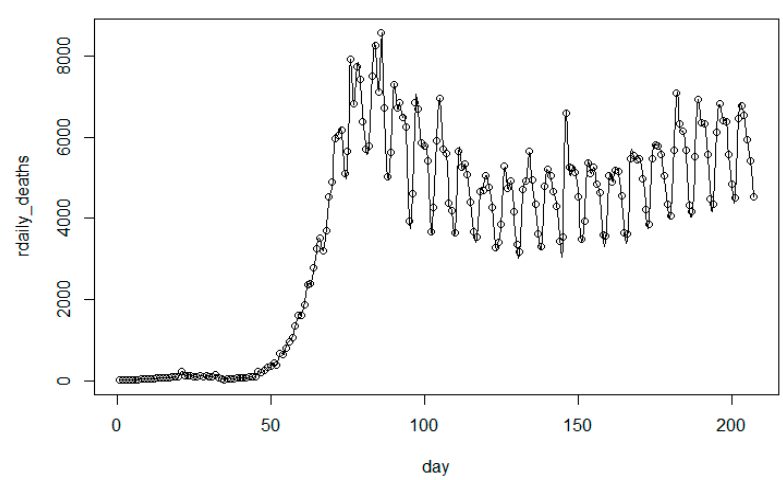
Figure 6. Worldwide cumulative number of deaths over time.